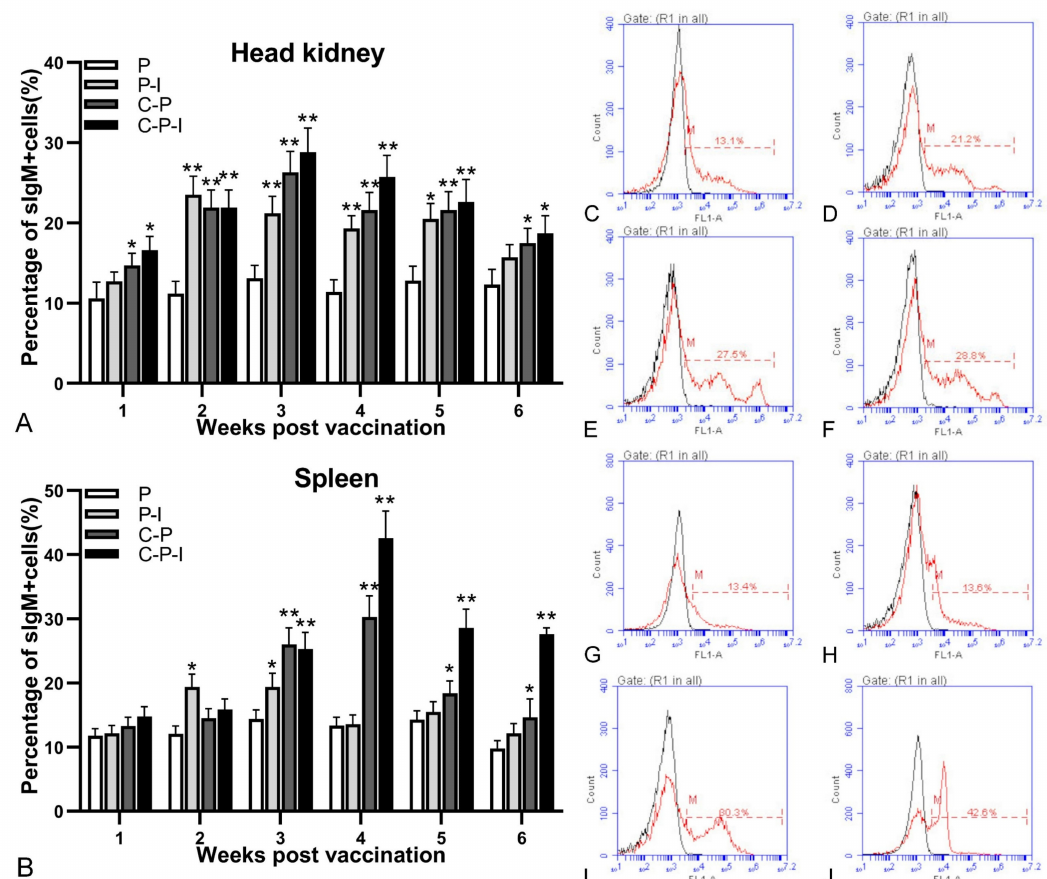
Figure 6. Variations of sIgM+ lymphocytes in head kidney and spleen. Changes in the percentage of sIgM+ lymphocytes in head kidney and spleen after immunization ( A , B ). Fluorescence histogram of gated lymphocytes (R1) showing the percentages of sIgM+ lymphocytes (scale of M) in the head kidney at the 3rd week post-immunization and spleen at the 4th week post-immunization of P, P-I, C-P, and C-P-I immunized fish ( C – J ). P: pBudCE4.1 group; P-I: pBudCE4.1-IRF3 group; C-P: CP-pBudCE4.1 group; C-P-I: CP-pBudCE4.1-IRF3 group. The data are presented as the means ± SD of three fish. Asterisks (*) on the bar represent the statistically significant difference, * p < 0.05, ** p <